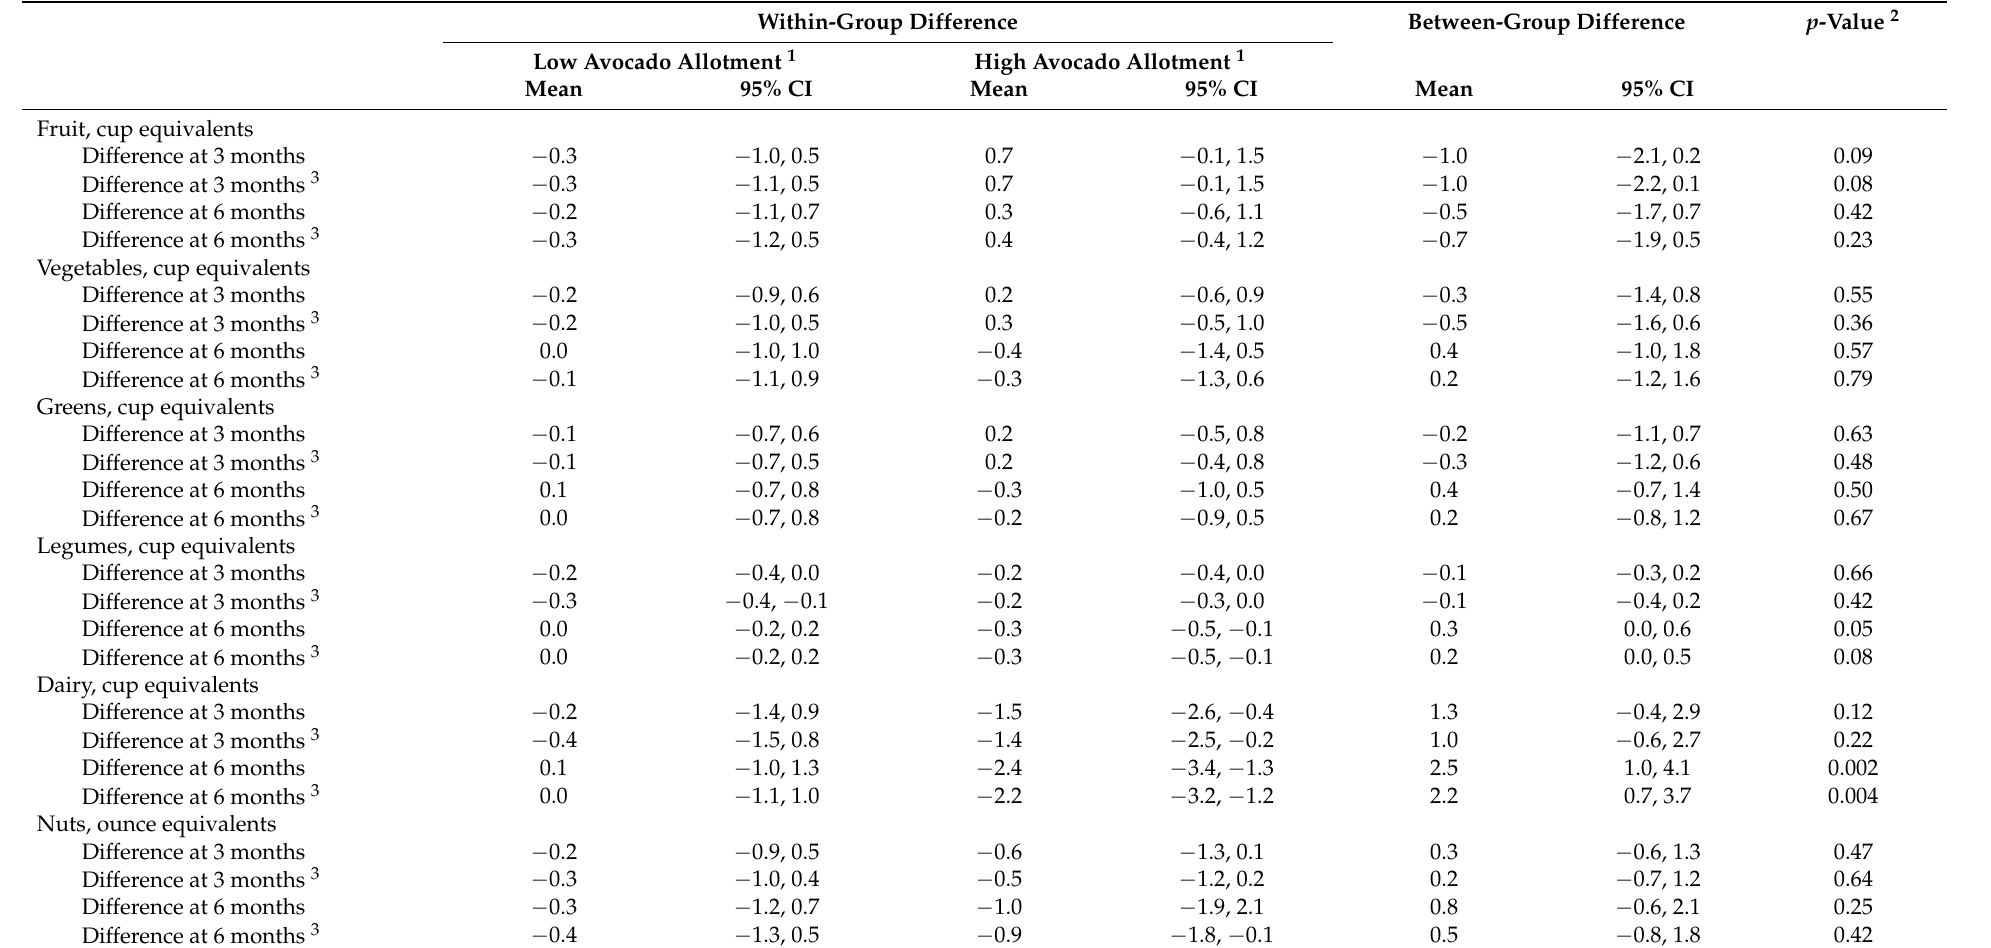
Table 8. Changes in family food group composition, per protocol adherence analysis, in the Effects of Avocado Intake on the Nutritional Status of Families Trial. Within-Group Difference Between-Group Difference p -Value 2 Low Avocado Allotment